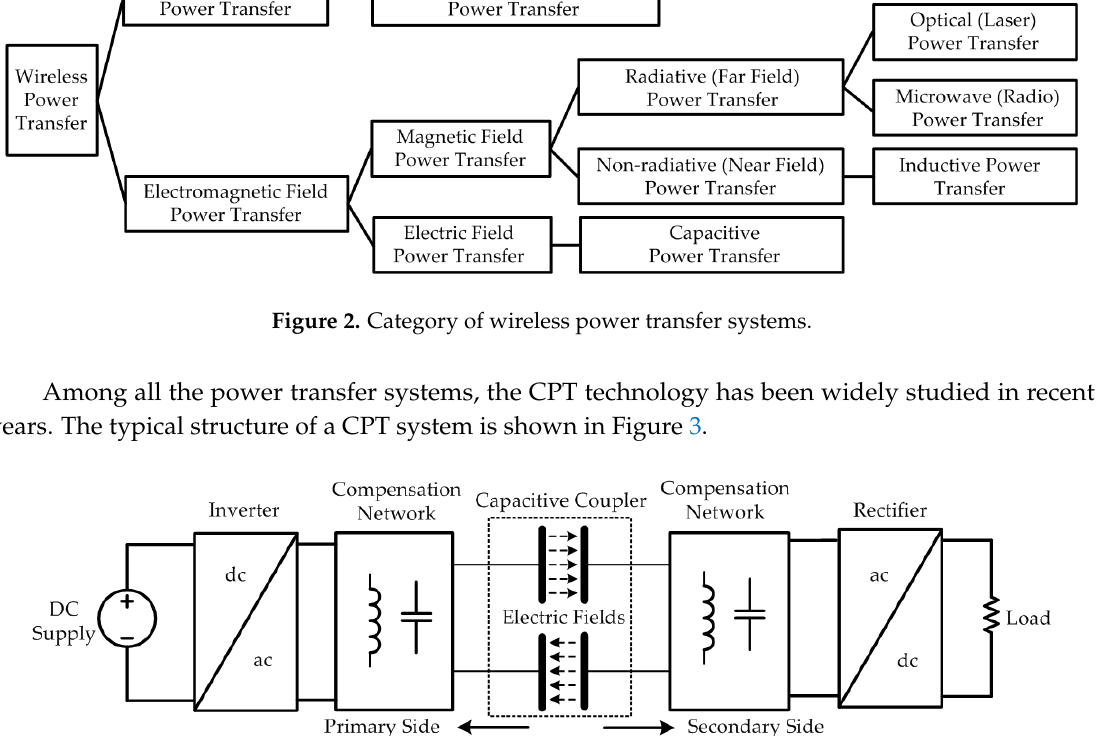
Figure 3. Typical structure of a capacitive power transfer (CPT) system.